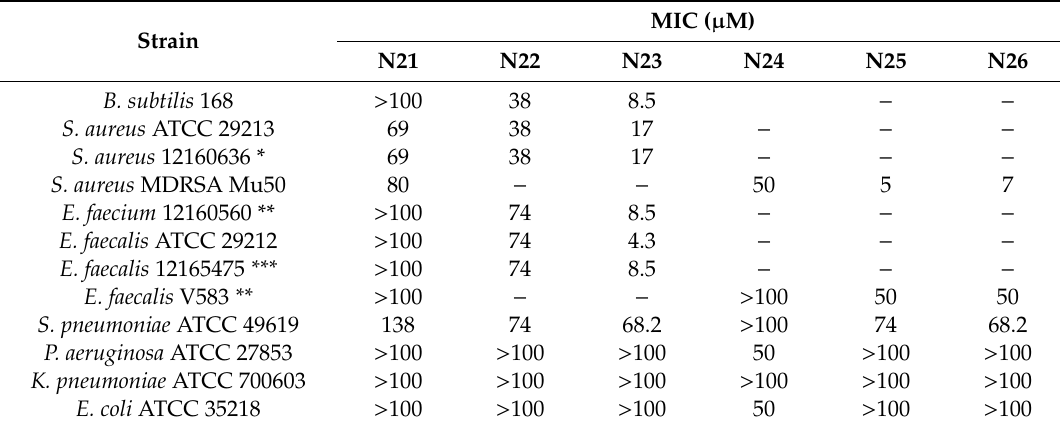
Table 5. MICs of non-nucleotide GTP analogues